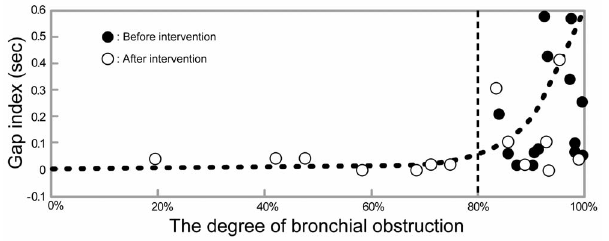
Figure 2. Scatter plot of the gap index versus the degree of bronchial obstruction. Closed circles, before-intervention; open circles, after-intervention. This figure shows the correlations between the gap index and the degree of bronchial obstruction in the bronchial obstruction group. The gap index more than 0.06 sec was observed only when the degree of bronchial obstruction was more than 80%. The gap index of cases with 80% or more unilateral bronchial obstruction (0.18 6 0.18 seconds) was significantly higher than cases with less than 80% obstruction (0.02 6 0.02 seconds, p , 0.05).